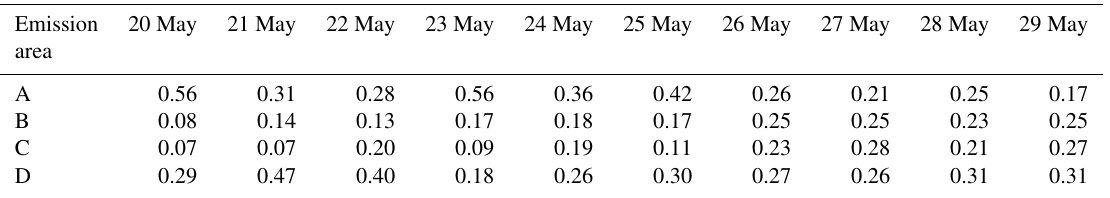
Table 1. Series of emission coefficients obtained by numerical solving of the difference between Q S1 and Q S3 applied to individual emission areas to fit the bLS-R model to concentration measurements on each day. For a grazed field with homogenous emissions the emission coefficients for each area would be 0.25. Therefore, the emission coefficients offset the bias in emission estimates between the sensors S1 and S3 by adjusting to the heterogeneity in emissions across the field area.